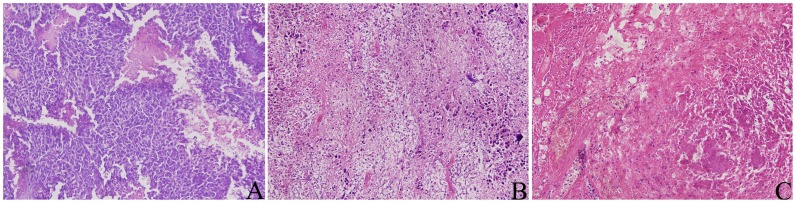
Hematoxylin and eosin staining of the tumor tissues.(A) 1 day prior to the IRE operation, the tumor cells displayed a large nucleus surrounded by a well marked cytoplasm and a well defined cell membrane; (B) 1 day after IRE, obvious tissue necrosis appeared; (C) 3 days after IRE, a continued increase in cellular eosinophilia, vascular congestion and inflammatory cell infiltration was observed (×200).